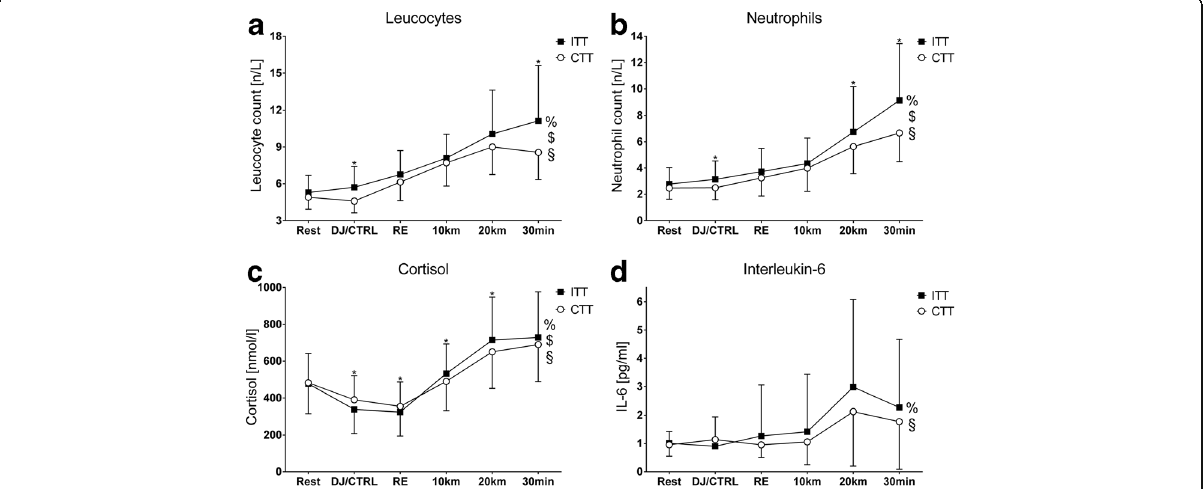
Fig. 1 Differential responses in haematological markers of muscle damage, muscle metabolic strain, and endocrinological stress response. Panels show: a = blood leucocyte count; b = blood neutrophil count; c = blood cortisol concentration; d = blood interleukin-6 concentration. Note: blood interleukin-6 concentrations violated the assumption of normal distribution and thus non-parametric ANOVA after aligned rank transformation was conducted. Despite a significant interaction effect, simple main treatment effects did not reach significance. Abbreviations: # = main time effect; & = main group effect; % = time×group interaction effect; $ = simple (main) time effect for intervention trials; § = simple (main) time effect for control trials; * = simple (main) trial effect; ITT = intervention time trial; CTT = control time trial; DJ = drop-jump protocol; CTRL = control; RE = running